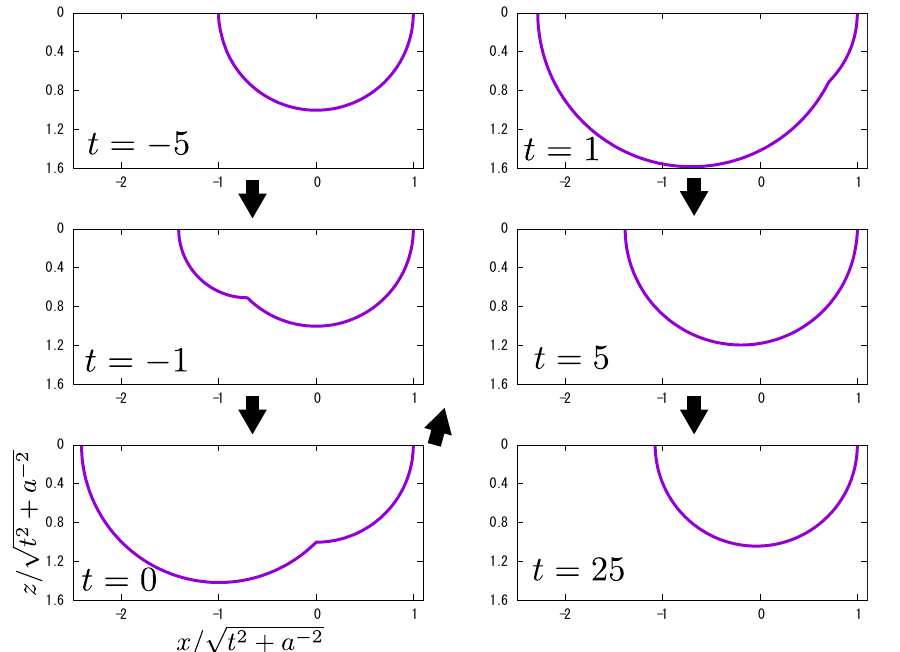
Figure 2. Time evolution of the string profile for several fixed time slices. Parameters are set as τ 0 = 14 . 51, a = 1 and a ′ = a + 10 − 6 . Horizontal and vertical axes are proportional to x and z − coordinates. They are normalized by √ t 2 + a − 2 to make the unperturbed string